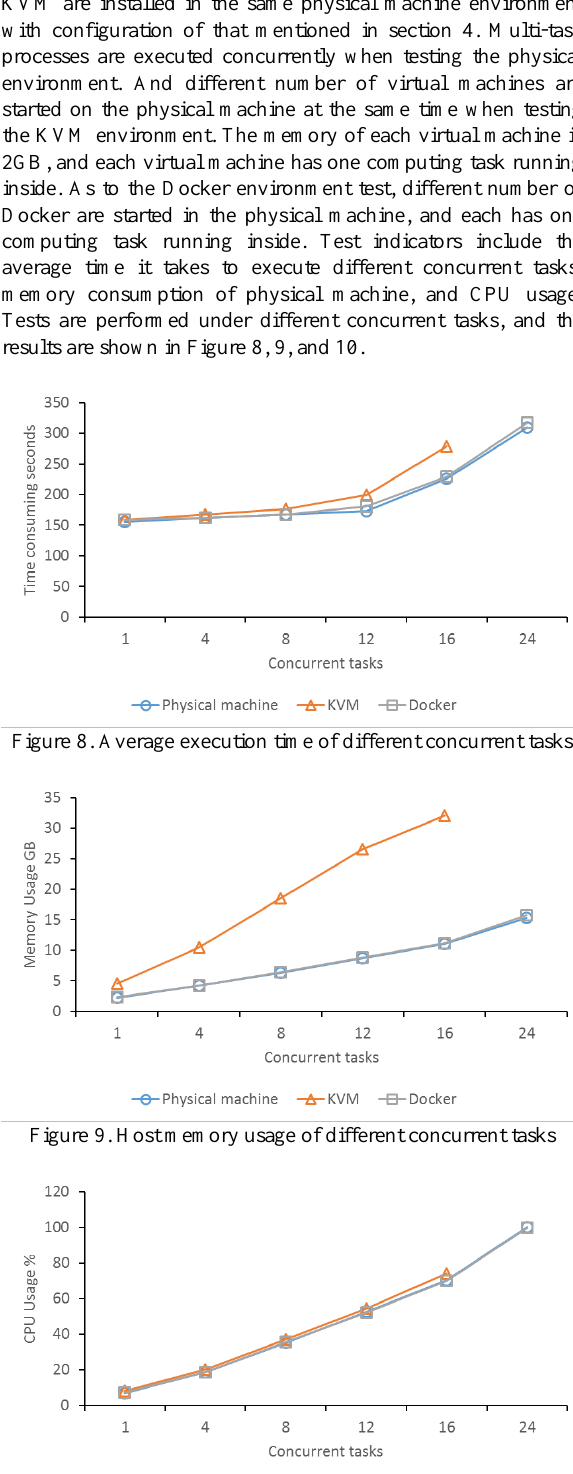
Figure 7. The data process workflow